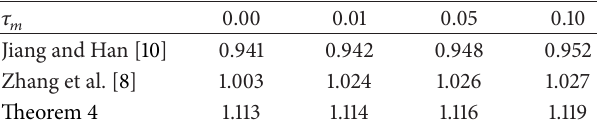
Table 1: Admissible upper bound 𝜏 𝑀 for various 𝜏 𝑚 .